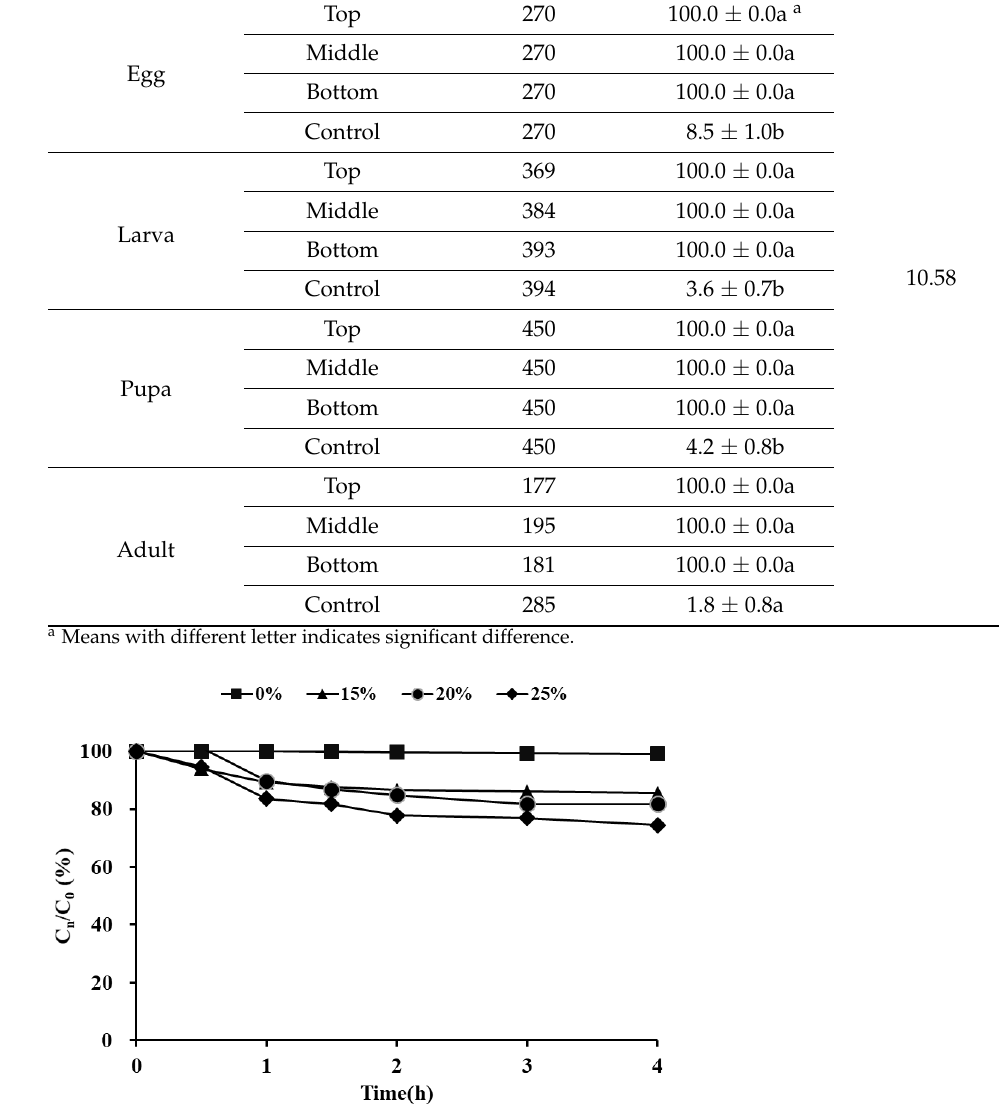
Figure 3. Concentrations of PH 3 at different grape loading ratios (0, 15%, 20%, and 25%) during fumigation in a 12 L desiccator with 3 mg/L PH 3 for 4 h.